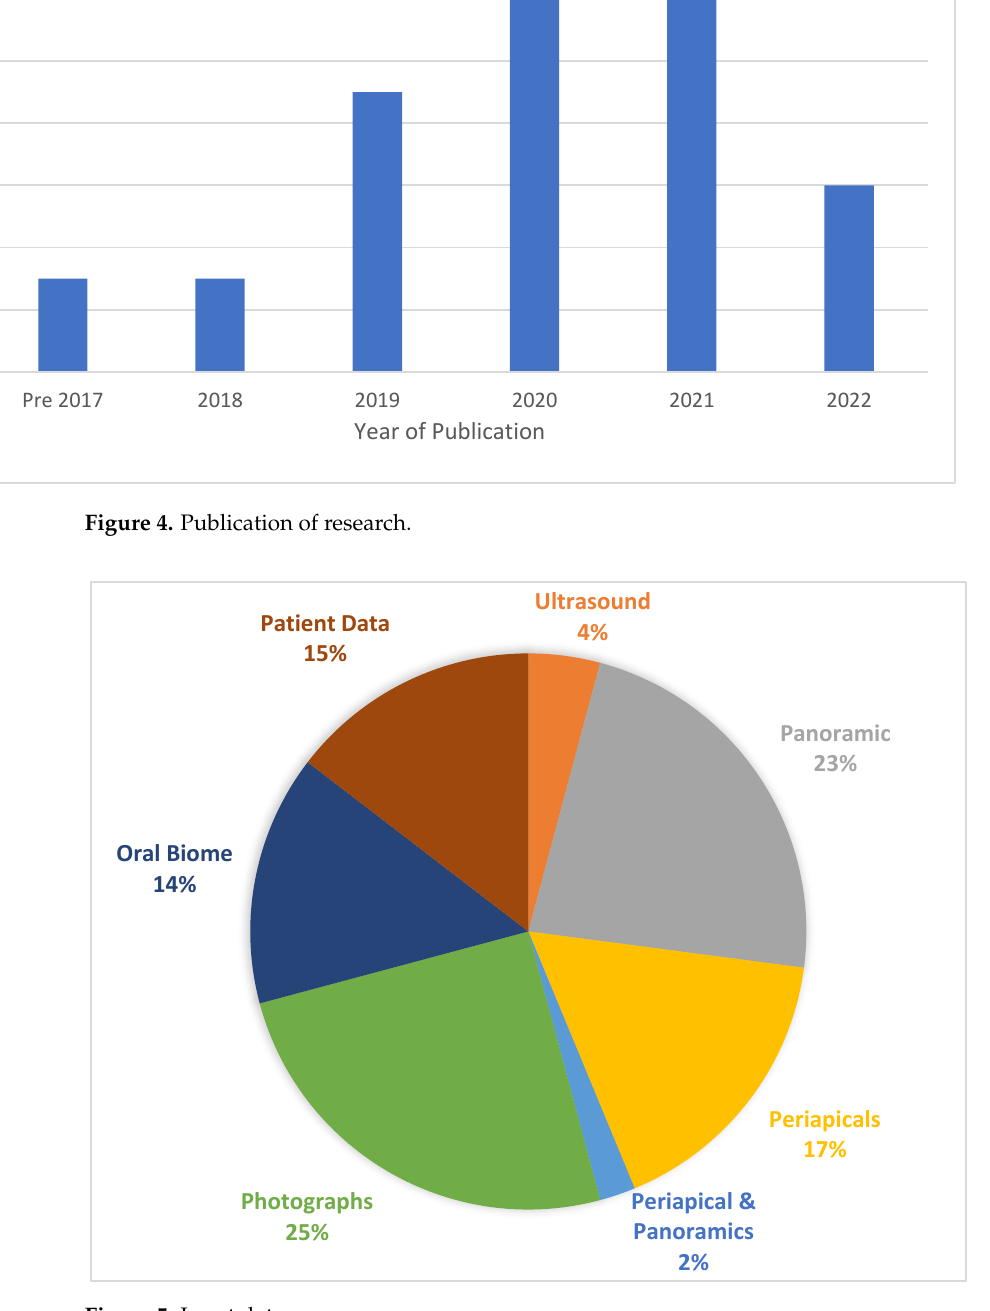
Figure 5. Input data.